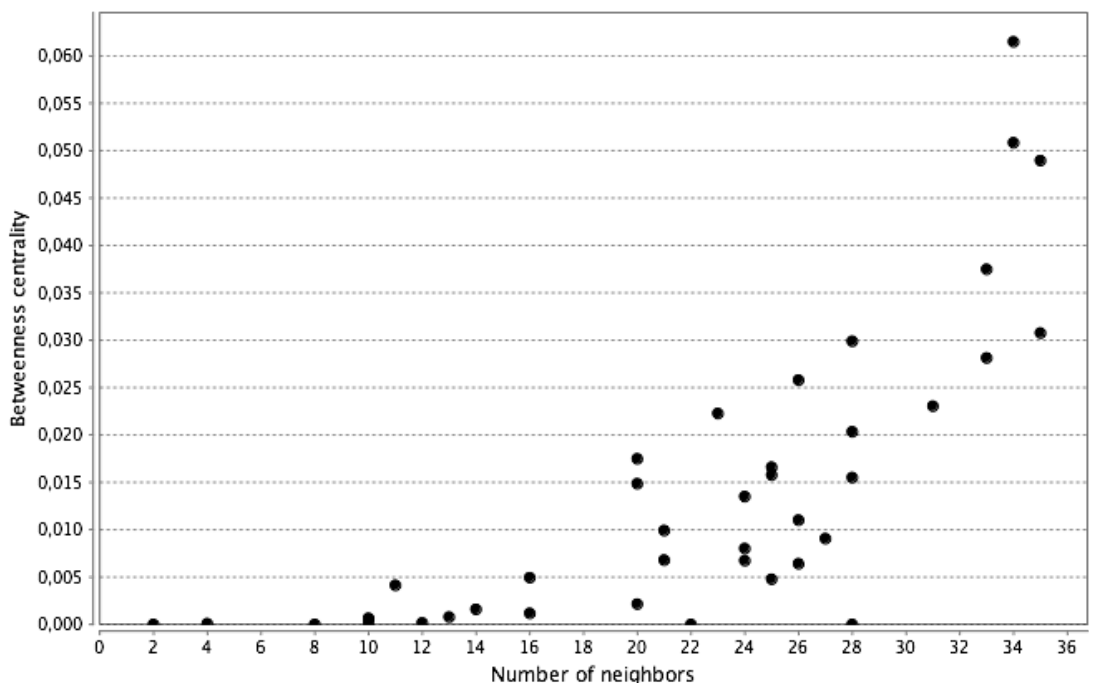
Figure 15 . Betweenness centrality of the Apps conversational